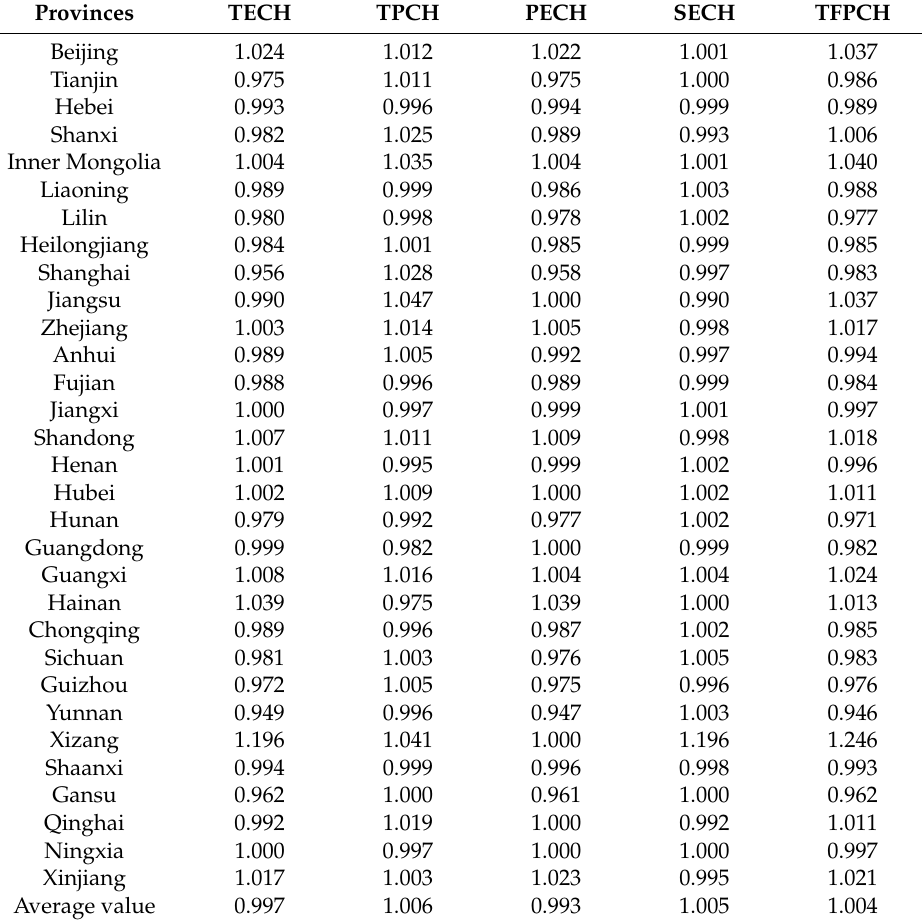
Table 1. Provincial TFEEs of thermal power industry from 2005 to